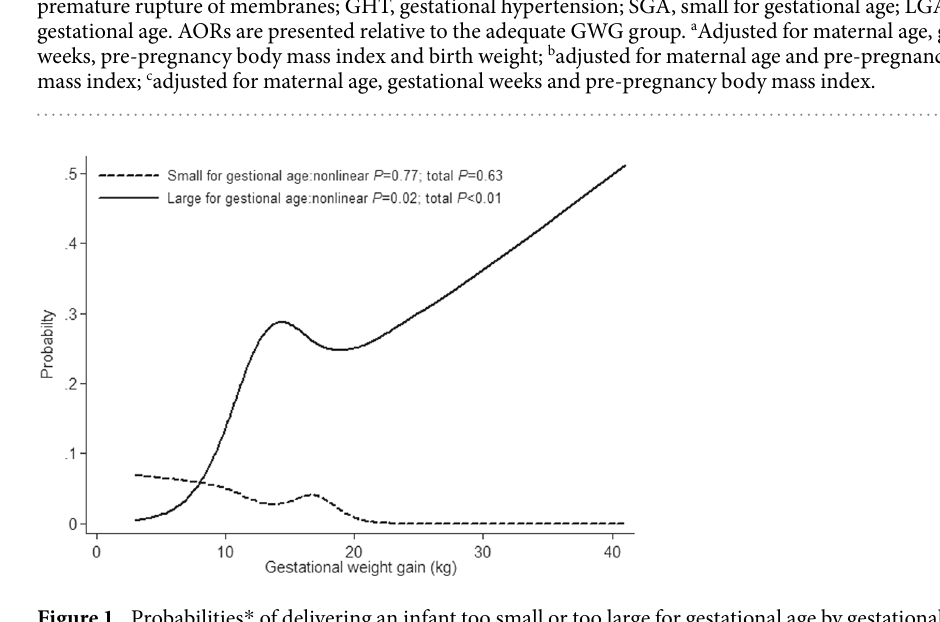
Figure 1. Probabilities * of delivering an infant too small or too large for gestational age by gestational weight gain in women with a normal† body mass index (BMI), Nanjing, China. * Logistic regression analyses with cubic splines adjusted by maternal age, parity and gestational weeks. † BMI ≥ 18.5 but < 23.9 kg/m 2